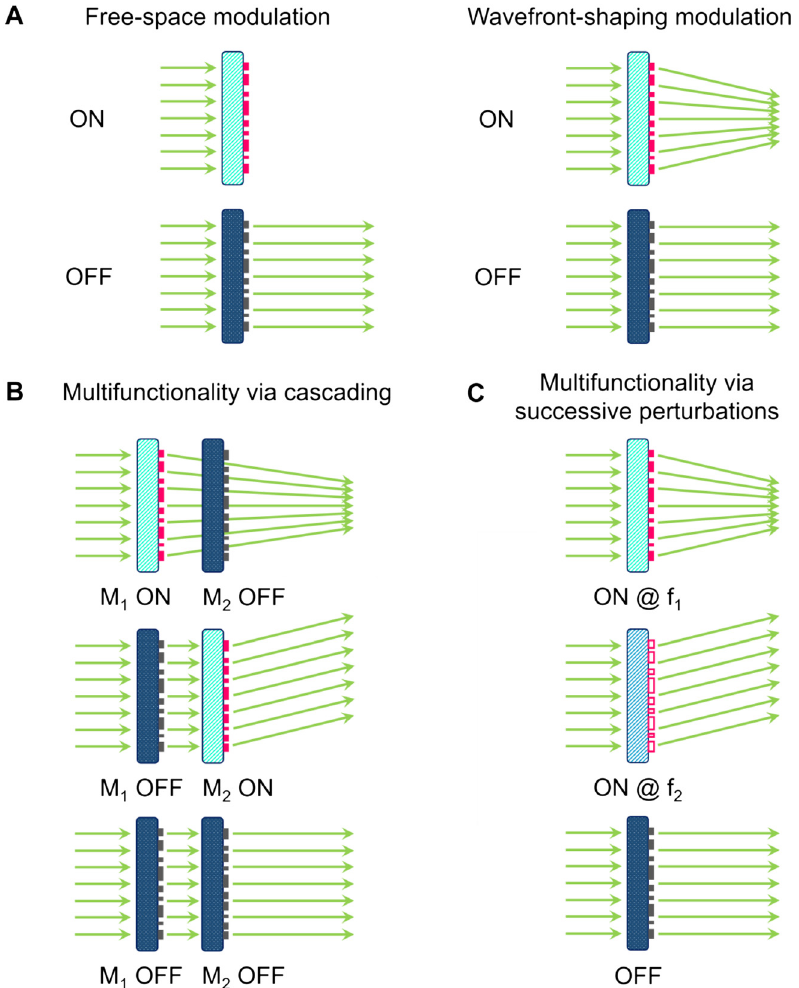
Figure 1: Schematics illustrating several functionalities of nonlocal metasurface